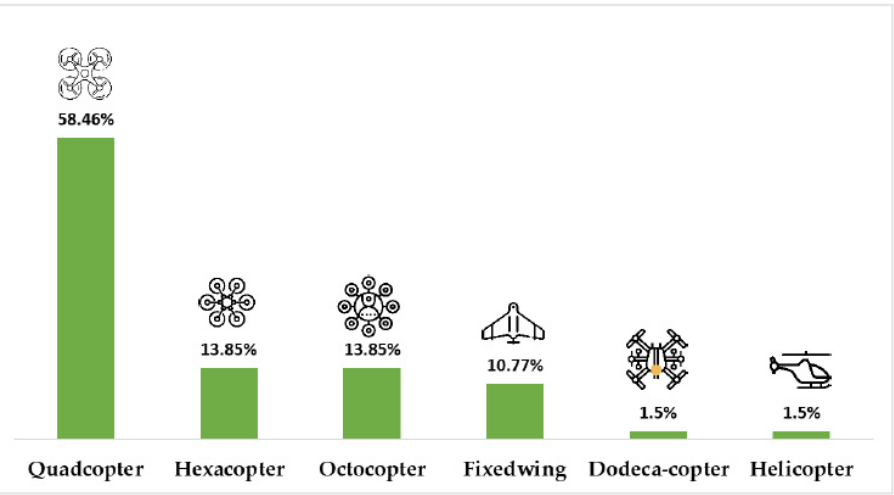
Figure 4. UAV platform types utilized per article.